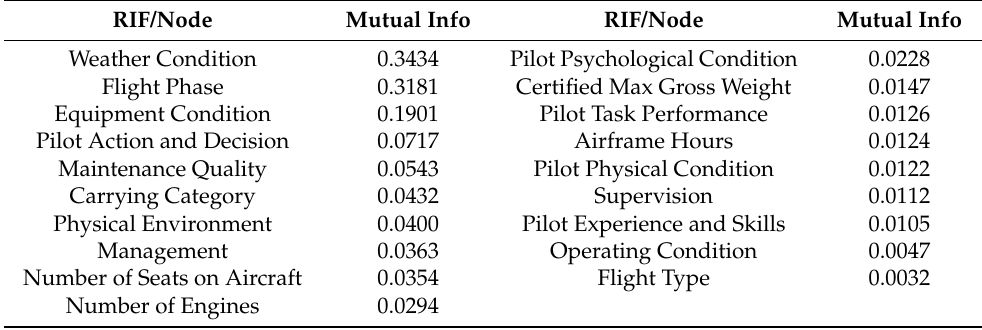
Table 3. Mutual information (MI) between “casualty type” and individual RIFs.